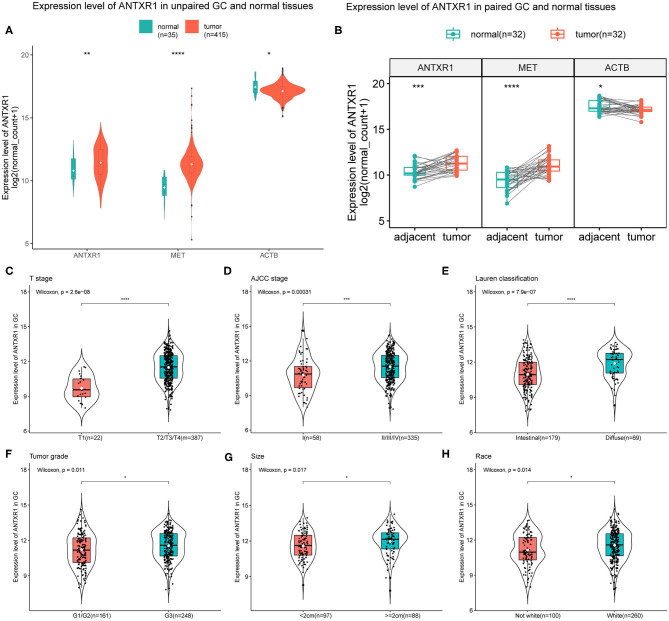
Elevated expression level of ANTXR1 correlated with aggravation of gastric cancer. (A) Expression level of ANTXR1 in unpaired tumor and adjacent tissues. (B) Expression level of ANTXR1 in unpaired tumor and adjacent tissues. MET and ACTB gene expression were considered as positive and negative control, respectively. (C–H) Comparisons of ANTXR1 expression levels in different clinical features in GC. (C) T stage, (D) AJCC stage, (E) Lauren classification, (F) histological grade, (G) tumor size, and (H) race. Box plots elements (center line, median; box boundaries, upper and lower quartiles; whiskers, maximum and minimum). *P < 0.05, **P < 0.01, ***P < 0.001, ****P < 0.0001.